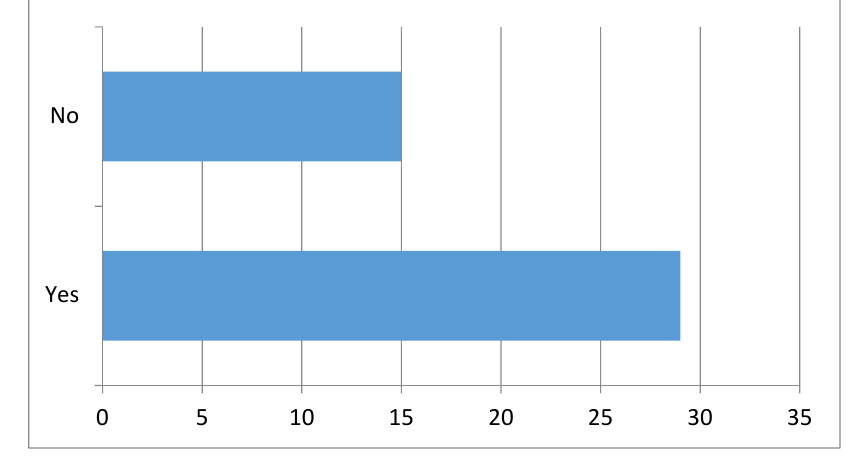
Figure 7. Awareness of Open Access.